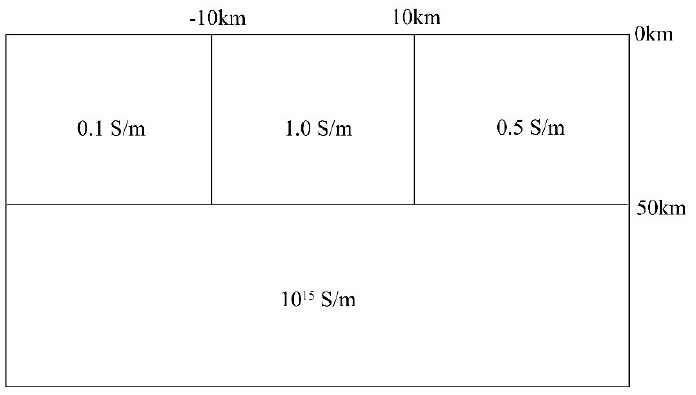
Figure 5. Schematic drawing of the COMMEMI 2D-0 model.